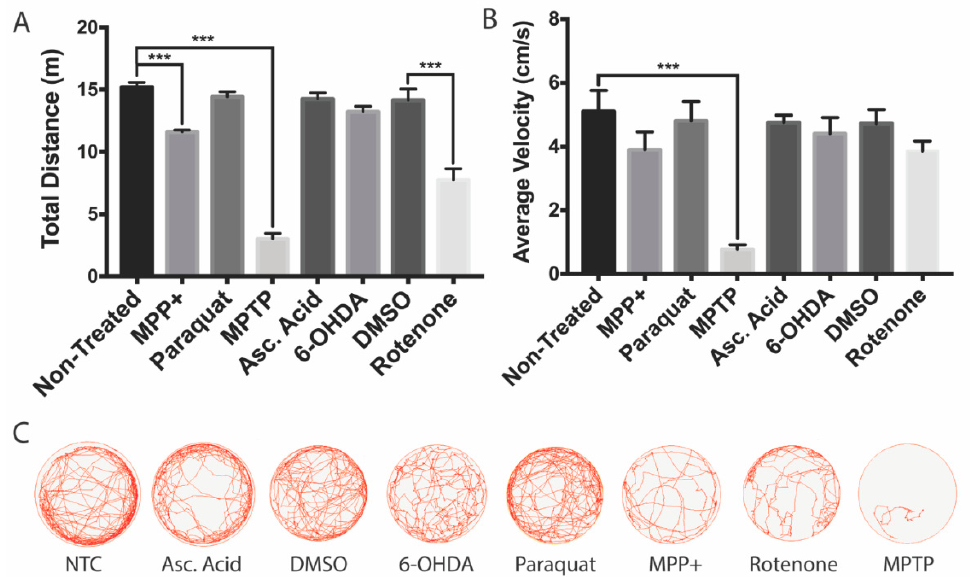
Figure 5. Swimming activity of zebrafish larvae following neurotoxin exposure. All zebrafish were transferred to acclimate to a 6-well plate for 15 mins prior to behavioral analyses. ( A – B ) Effects of MPTP, MPP + , 6-OHDA, paraquat, and rotenone on total swim distance and average swimming velocity ( n = 20–25 larvae). ( C ) Overhead path images of a representative larvae for each exposure group. Bars represent the Mean ± the SEM. *** ( p < 0.001).